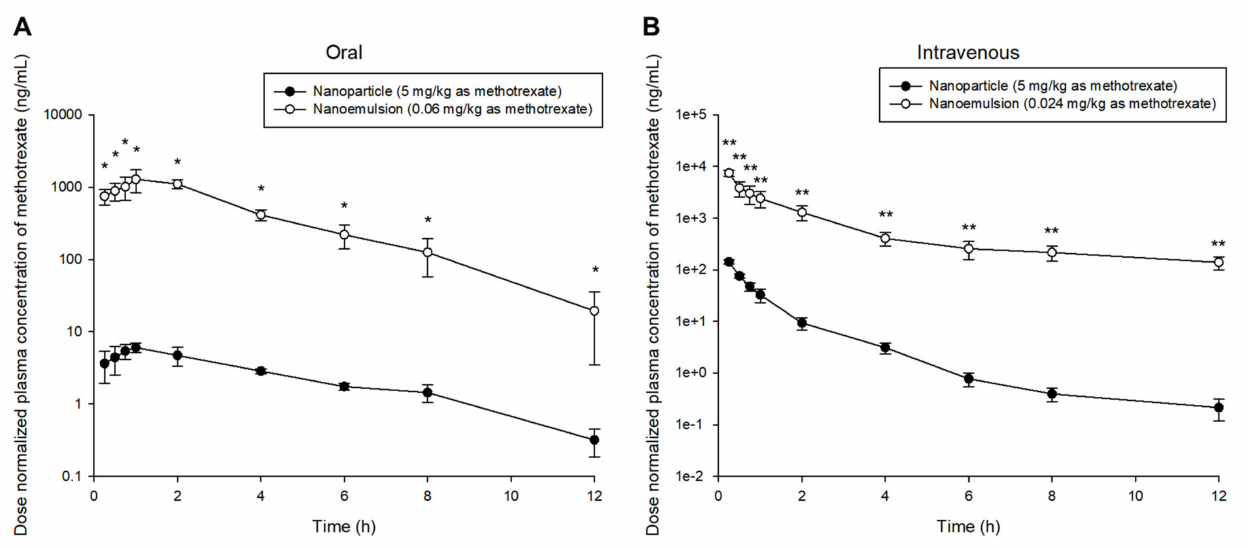
Figure 4. Dose-normalized mean plasma concentration-time profiles of methotrexate after oral ( A ) or intravenous ( B ) admin- istration of methotrexate-loaded nanoparticles (- • -, 5 mg/kg as methotrexate) and methotrexate-loaded nanoemulsions (- 0.06 or 0.024 mg/kg as methotrexate) in rats. Vertical bars represent standard deviation of the mean ( n = 5). * p < 0.05 com- pared with the oral administration of nanoparticle. ** p < 0.05 compared with the intravenous administration of